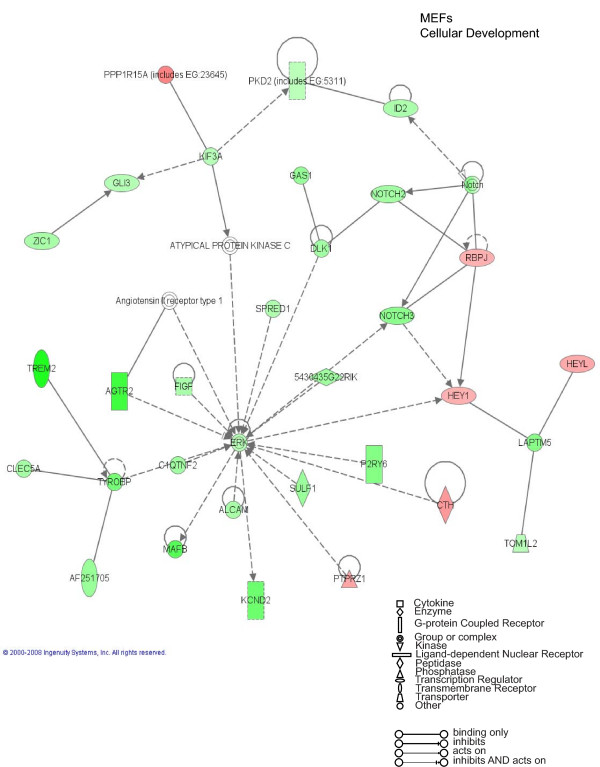
Cellular Development: Ingenuity Pathway Analysis for mouse embryo fibroblasts (MEFs). Specific functional networks of the newly identified AP-2α-regulated genes were obtained using Ingenuity Pathway Analysis systems and "cellular development" is one of the two main networks found. Gene products are represented as nodes and biological relationships between two nodes as a line. Continuous lines indicate direct interactions, while dashed lines represent indirect connections. Shapes of nodes symbolize functional classes of gene products (see the figure legend). The green and red symbols represent down- and up-regulation, respectively, while the white symbols indicate genes absent in the dataset but related with the dataset genes.